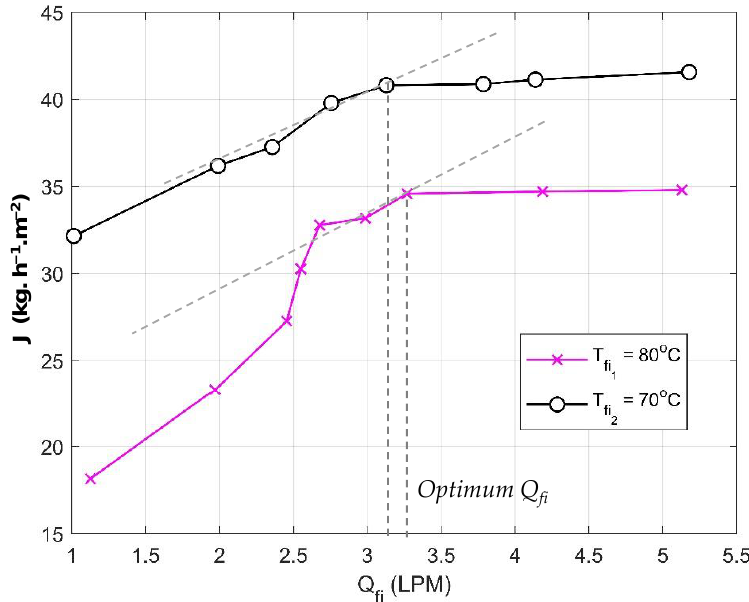
Figure 9. Mass flux (J) with respect to feed flow (Q fi ).